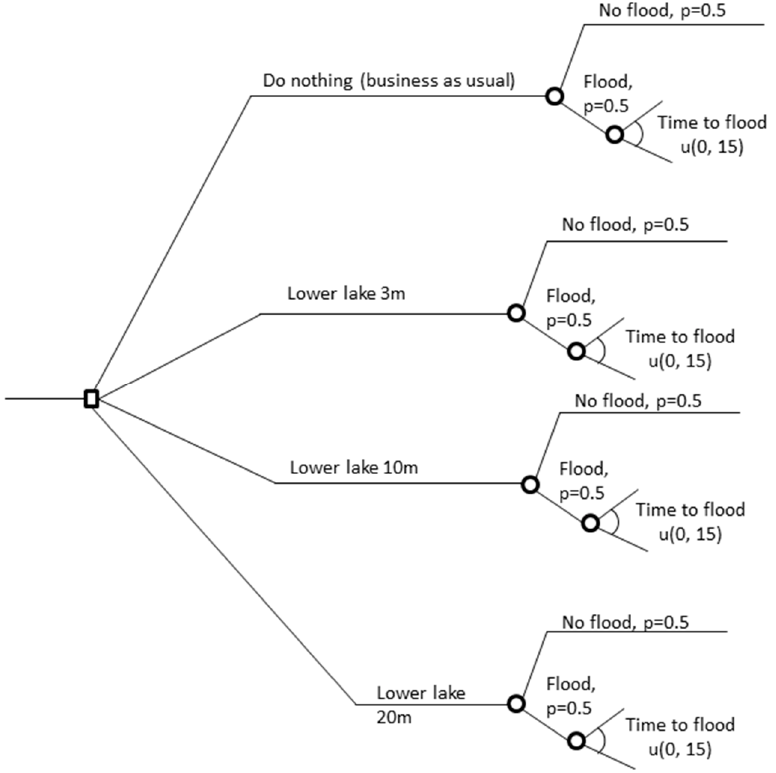
Figure 3. The decision tree for Imja GLOF risk mitigation shows potential lake lowering amounts, flood probabilities, and time to flooding.